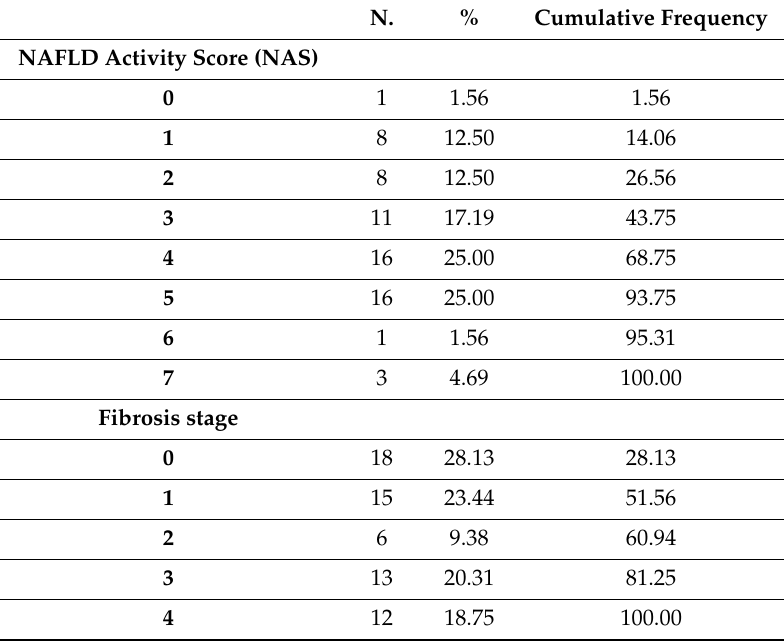
Table A2. Distribution of NAFLD patients (N. = 64) according to Kleiner classification system. HCC subjects are not